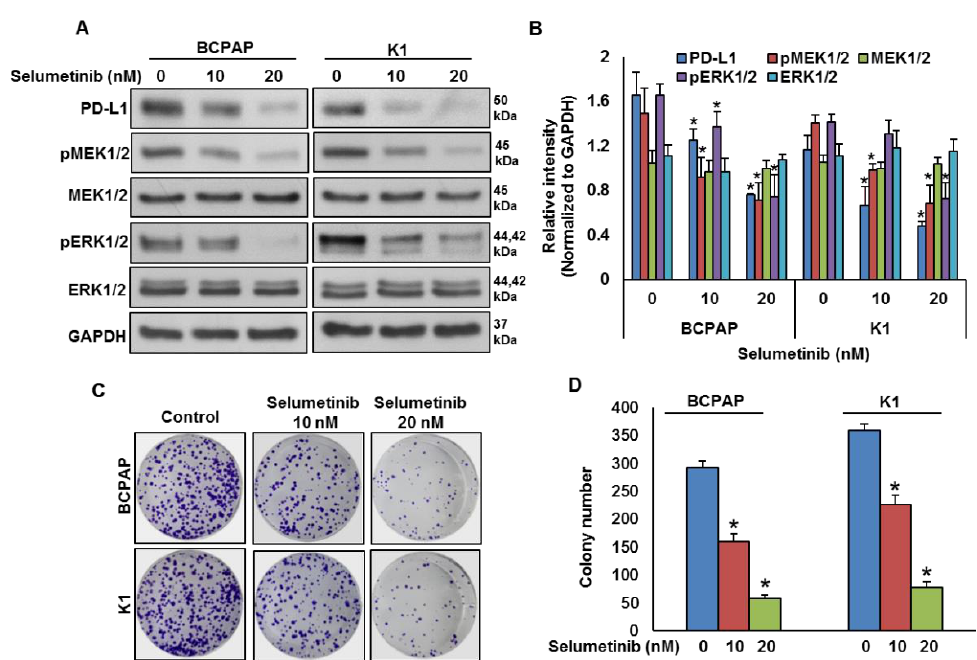
Figure 4. MEK inhibition downregulates PD-L1 expression and decreases cell growth. ( A , B ) MEK inhibition downregulates PD-L1 expression. BRAF -mutated cells were treated with indicated doses of selumetinib for 48 h. After cell lysis, equal amounts of proteins were separated by SDS-PAGE, transferred to immobilon membrane, and immuno-blotted with antibodies against PD-L1, pMEK1/2, MEK1/2, pERK1/2, ERK1/2 and GAPDH as indicated. Western blots were quantified and data are presented as mean ± SD of three independent experiments ( n = 3). * Indicates a statistically significant difference compared to control with p < 0.05. ( C , D ) MEK inhibition decreases cell growth. BRAF -mutated PTC cell lines were treated with indicated doses of selumetinib for 48 h. Cells (5 × 10 2 ) were then re-seeded into a 6-well plate, and grown for an additional 6–8 days, then stained with crystal violet and colonies were counted. Data presented in the bar graphs are the mean ± SD of three independent experiments ( n = 3) which were repeated at least two times with the same results. * Indicates a statistically significant difference compared to control with p < 0.05.